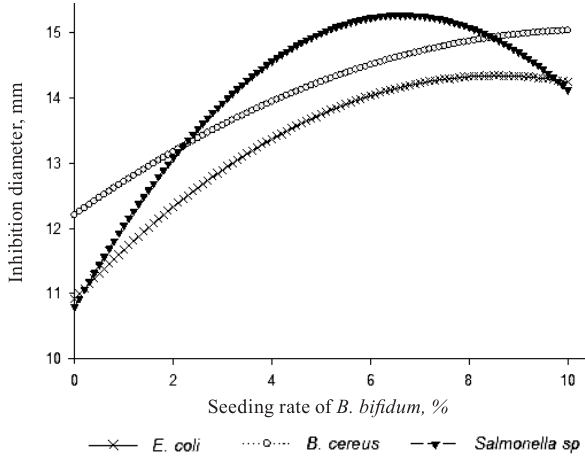
Figure 2 Individual effect of Bifidobacterium bifidum on Escherichia coli , Bacillus cereus , and Salmonella sp.